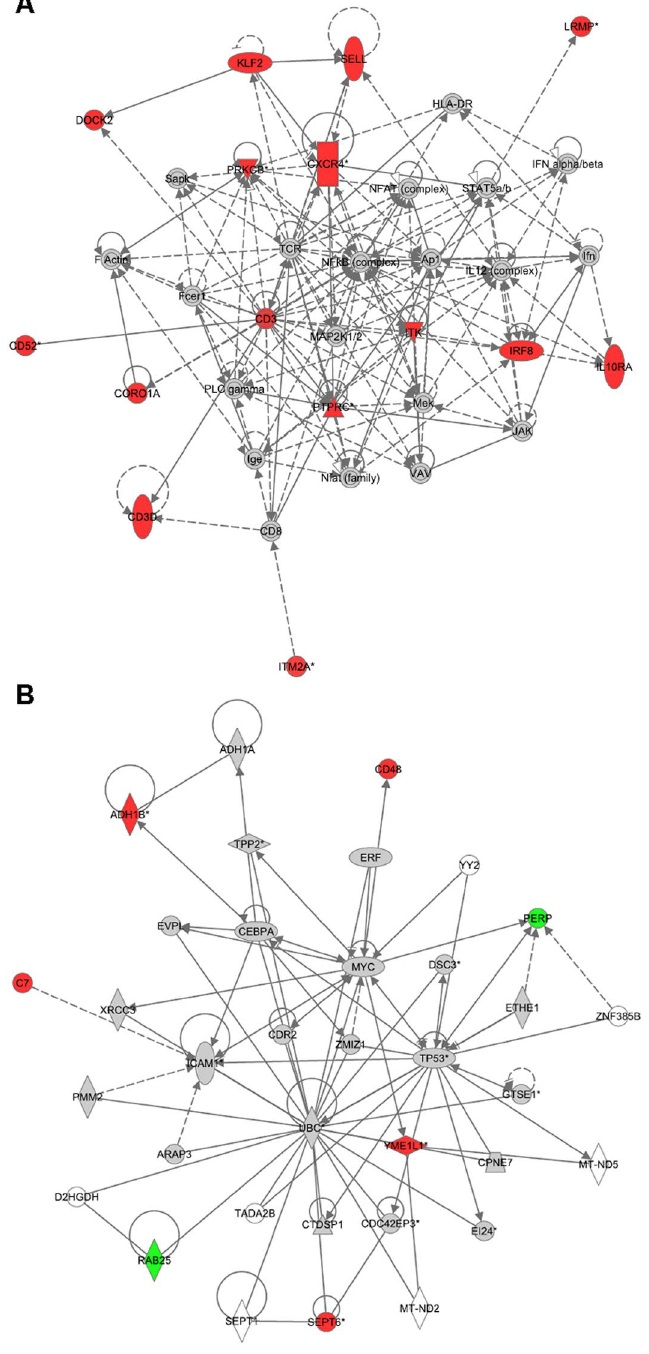
Figure 4. Top networks of differentially expressed genes in M vs .PT as identified by Ingenuity Pathway Analysis show strong association to cancer and connective tissue disorders. For network analyses a threshold of log 2 FC > |1.5| with a p-value < 0.0001 (corresponding to a FDR of 0.004) was used, giving an overview of involved genes within the networks and their differential expression. Node colour indicates up-regulated (red), down-regulated (green) or not significantly changed according to threshold (grey) genes. Lines and arrows between nodes represent direct (solid lines) and indirect (dashed lines) interactions between molecules. All edges are supported by at least one reference from the literature or from canonical information stored in the Ingenuity Knowledge Base. Node shapes represent functional classes of gene products: square → cytokine, triangle → kinase, rectangle → nuclear receptor, concentric circle → group or complex, vertical diamond → enzyme, horizontal diamond → peptidase, trapezium → transporter, vertical ellipse → transmembrane receptor horizontal ellipse → transcription regulator, circle → other. ( A ) Top 03 significant M vs .PT network (Cell-To-Cell Signalling and Interaction, Haematological System Development and Function, Tissue Morphology) contains 14 focus genes. ( B ) Top 07 significant M vs .PT network (Cancer, Endocrine System Disorders, Developmental Disorder) contains 7 focus